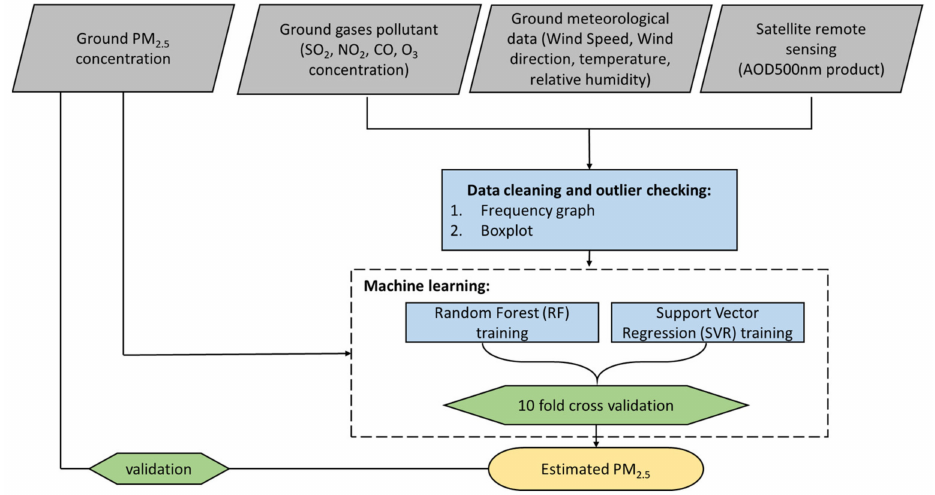
Figure 2. Flowchart of the overall dataset and methodology used for the estimations of PM 2.5